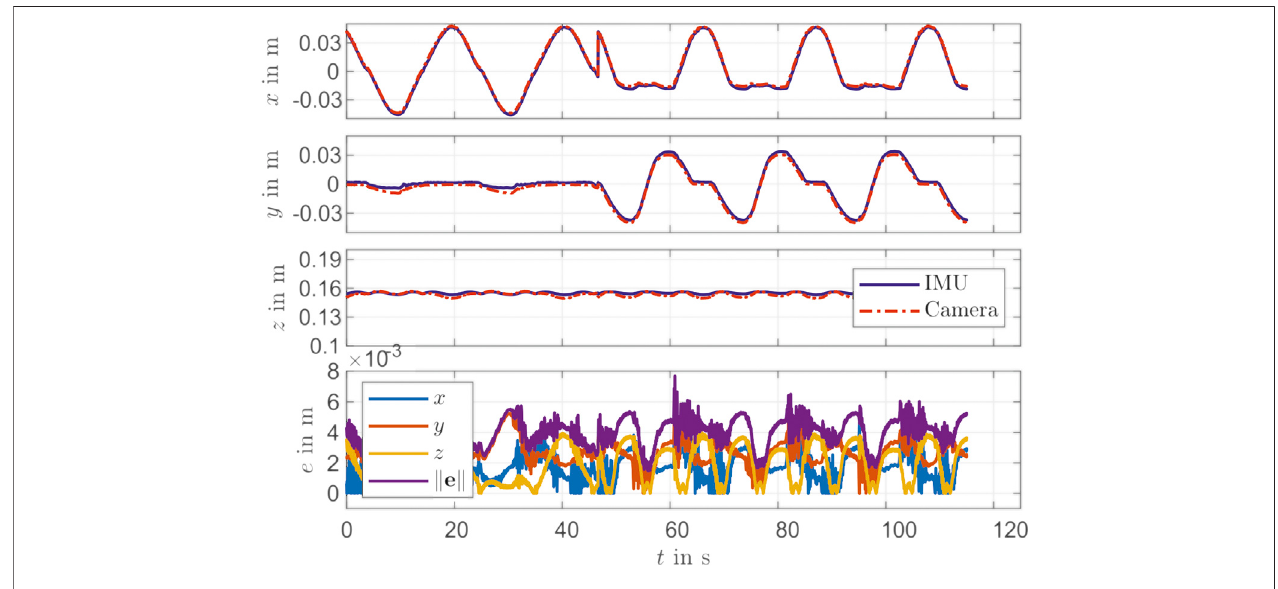
FIGURE 3 | Validation for IMU identi fi cation.